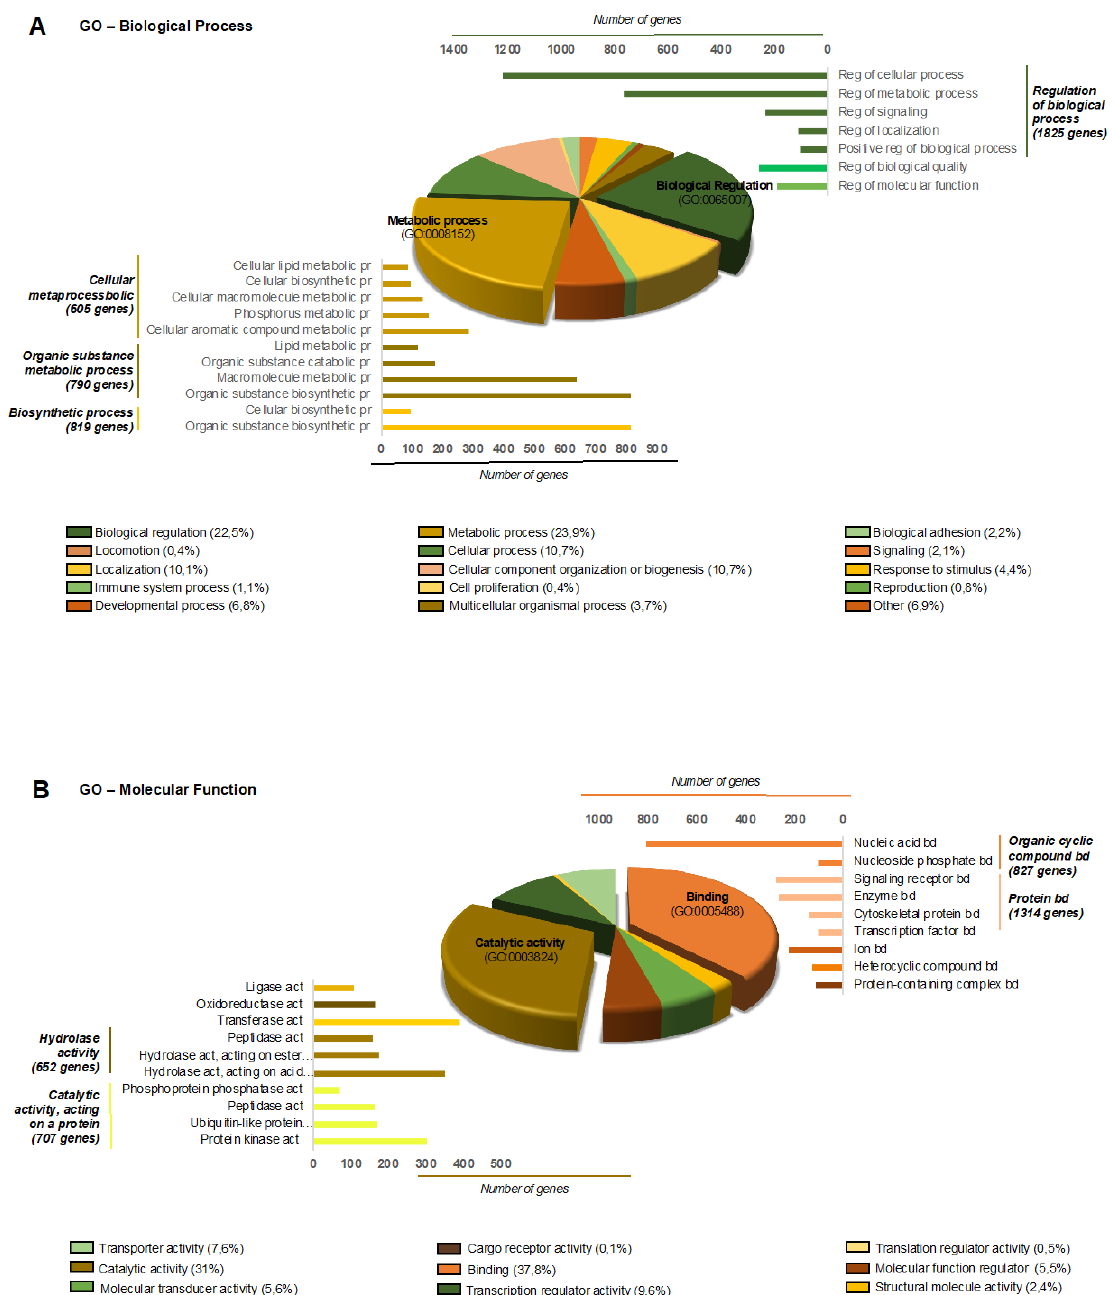
Figure 3. Gene Ontology (GO) analysis of the predicted proteins regulated by miRNA from EVs of EC and control patients: ( A ) Biological process GO analysis of predicted proteins regulated by di ff erentially expressed miRNA from the ELV of EC and control patients. A total of 8074 genes were predicted to be modulated by 114 miRNA and were included in at least one of the GO Biological process categories as indicated in the pie chart. Others include the following categories that have less than 0.4% of representation: growth; multi-organism process; biological phase; rhythmic process; pigmentation; nitrogen utilization. ( B ) Molecular Function GO analysis of predicted proteins regulated by di ff erentially expressed miRNA from the ELV of EC and control patients. A total of 8074 genes were predicted to be modulated by 115 miRNA and were included in at least one of the GO Molecular Function categories as indicated in the pie chart. Abbreviations: Reg, Regulation; Pr, Process; Bd, Binding; Act, Activity.